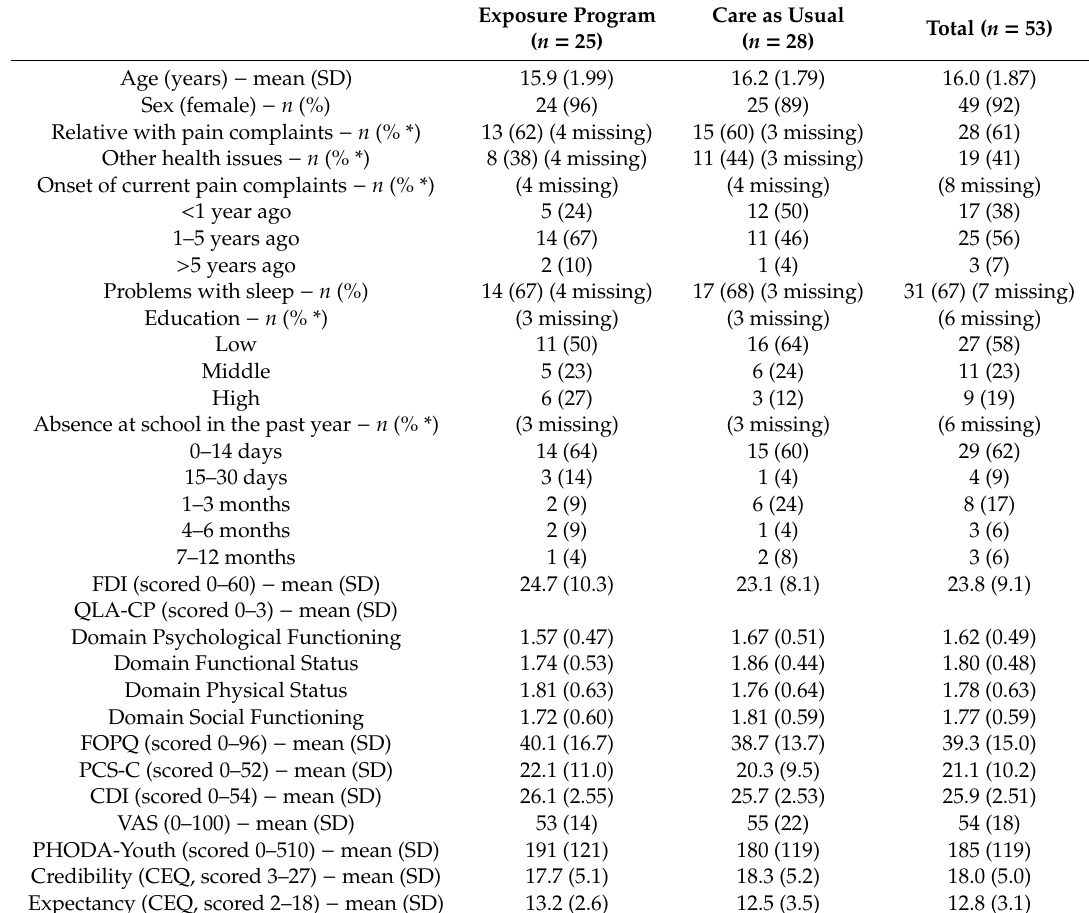
Table 2. Characteristics of study participants at baseline ( n = 53, n = 7